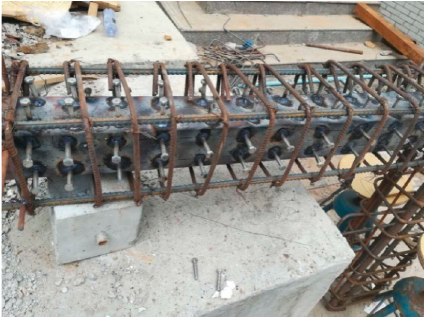
Figure 3: Stud connectors welded on the steel tube. Table 2: Components and mix proportions of the specimens.